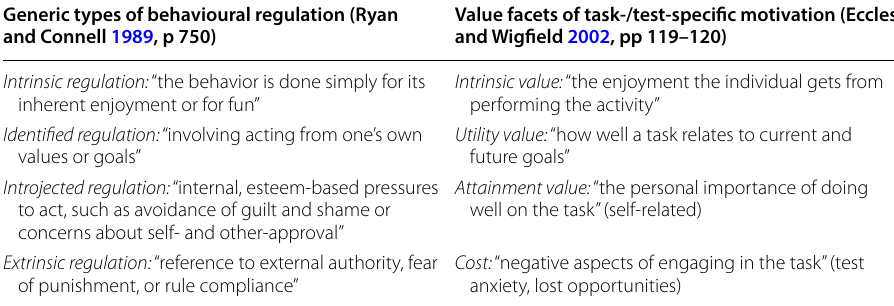
Table 1 Construct overlap between types of behavioural regulation and value facets of task/test motivation Generic types of behavioural regulation (Ryan and Connell 1989, p